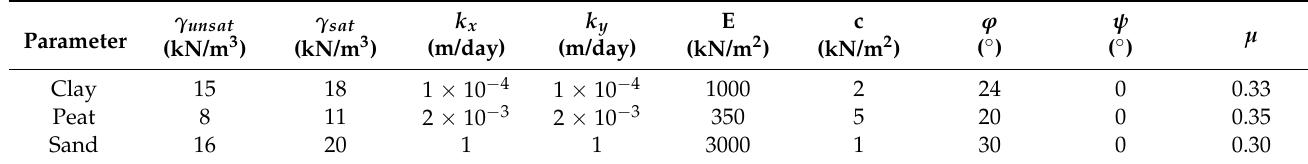
Table 1. Parameters of the